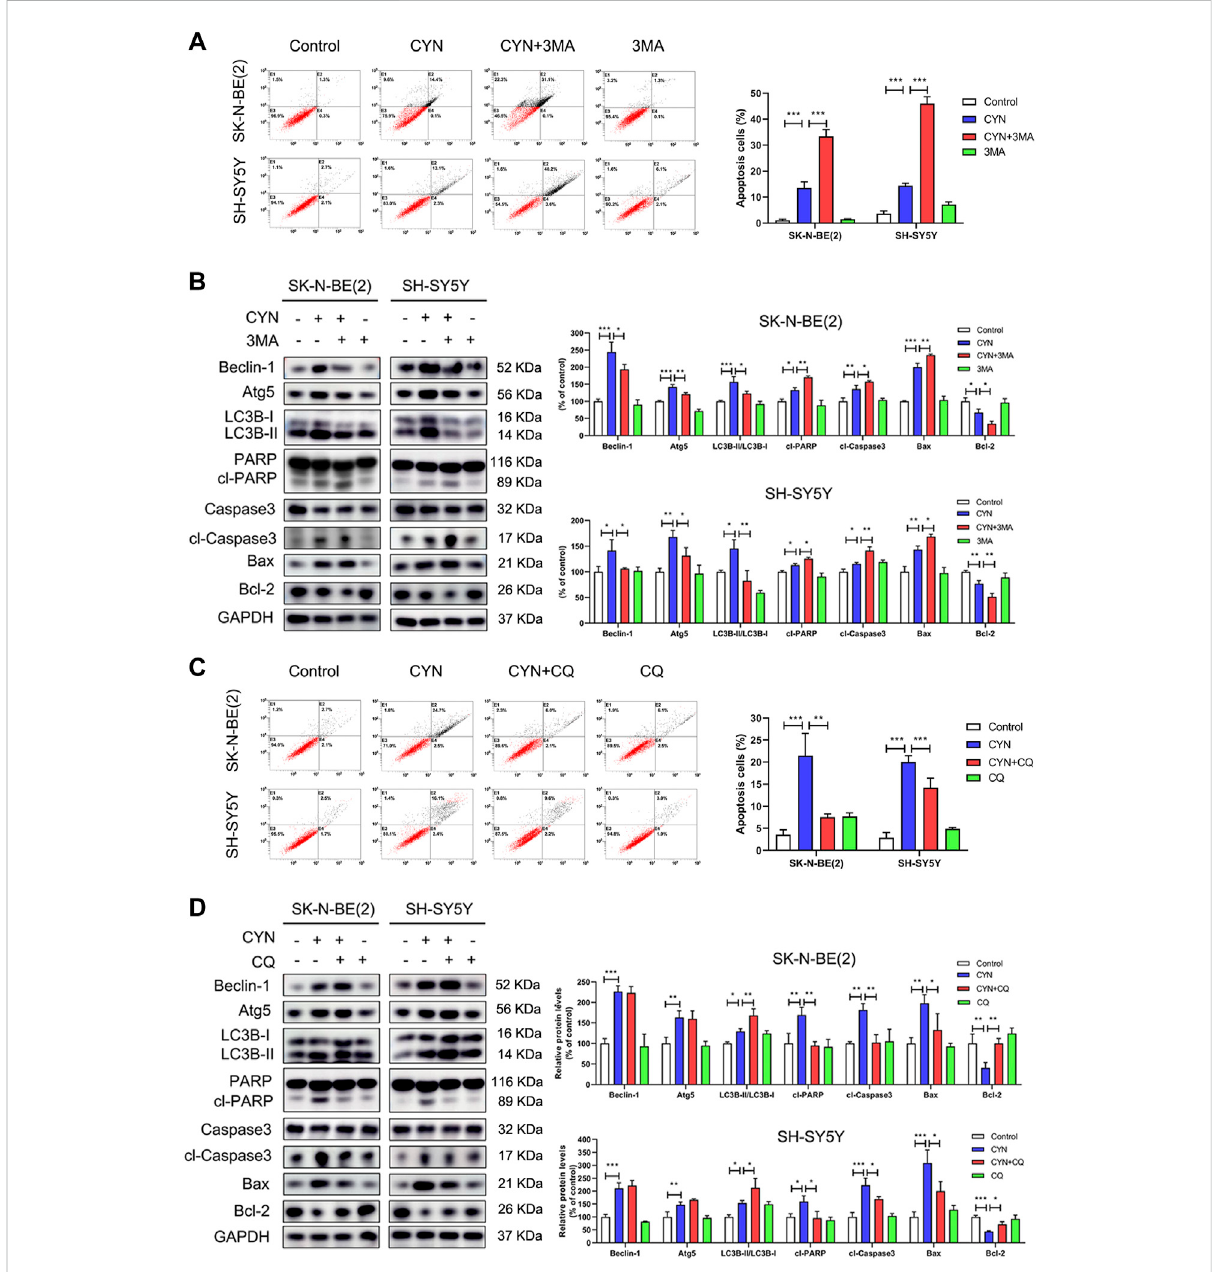
FIGURE 4 Relationship between apoptosis and autophagy in NB cells treated by CYN. (A) Apoptosis of NB cells was measured and analyzed by fl ow cytometry. (B) The expression levels of autophagy and apoptosis markers were analyzed by western blotting. (C) The number of apoptotic cells was assessed by Annexin V-FITC/PI staining and fl ow cytometry. (D) The expression levels of apoptosis markers were measured by western blot analysis. * p < 0.05, ** p < 0.01, *** p < 0.001 versus the control group. * p < 0.05, ** p < 0.01, *** p < 0.001 versus the CYN